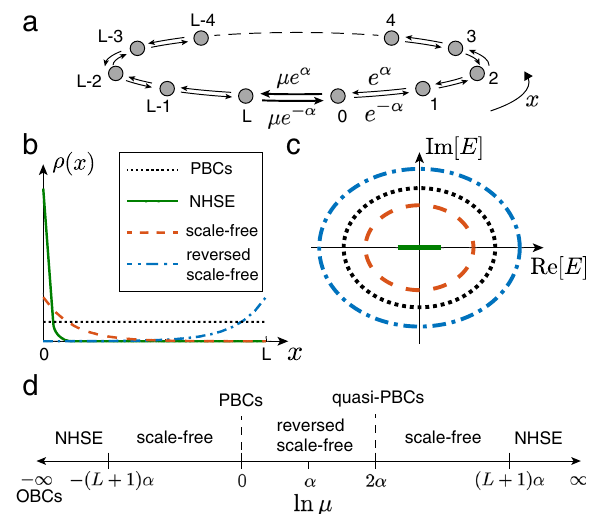
Fig. 1 Sketch of the impurity model and possible behaviors. a The Hatano – Nelson model with x = 0, 1, 2, . . ., L the number of lattice sites, e ± α the non-reciprocal nearest-neighbor couplings, and impurity couplings μ e ± α between the sites 0 and L . Periodic and open boundary conditions (PBCs and OBCs) correspond to μ = 1 and 0, respectively, but other μ support qualitatively different phenomena. b Spatial eigenstate distributions ρ ( x ) = ∣ ψ x ∣ 2 with different accumulating behaviors (normal and reversed scale-free accumulations, and the non-Hermitian skin effect (NHSE)), with ψ x the wave-function value at x . c Complex spectra with Re ½ E (cid:3) and Im ½ E (cid:3) the real and imaginary parts of the energies, distinguishing the four types of eigenstates in ( b ). d Different regimes across the whole range μ are marked by different accumulation phenomena, with dualities relating strong and weak μ